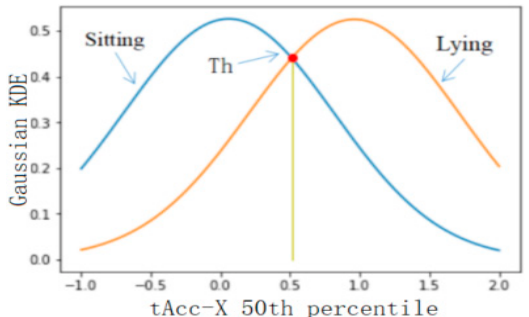
Figure 8. Probability distribution of upstairs and downstairs.